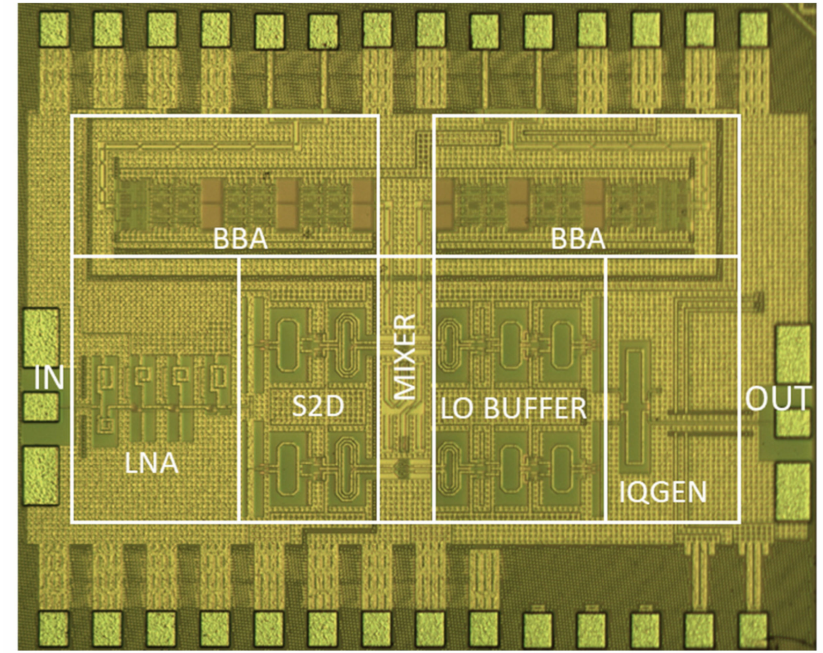
Figure 10. Chip microphotograph of 60 GHz CMOS I/Q receiver.